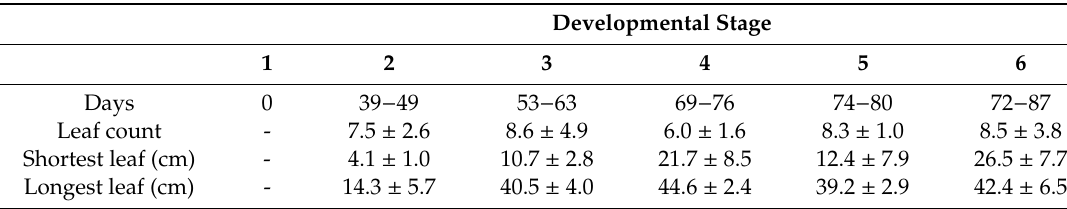
Table A1. Growth details of N. papyraceus plants measured by the number and length of their leaves. A minimum of five leaves was measured per stage.